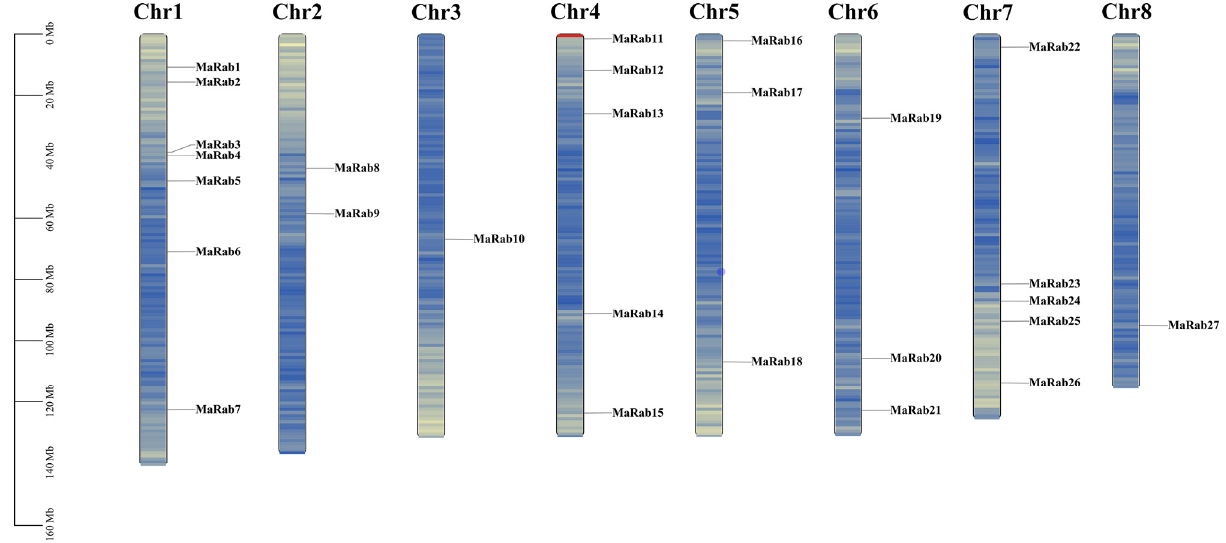
Figure 1. The chromosomal location of the MaRab genes.